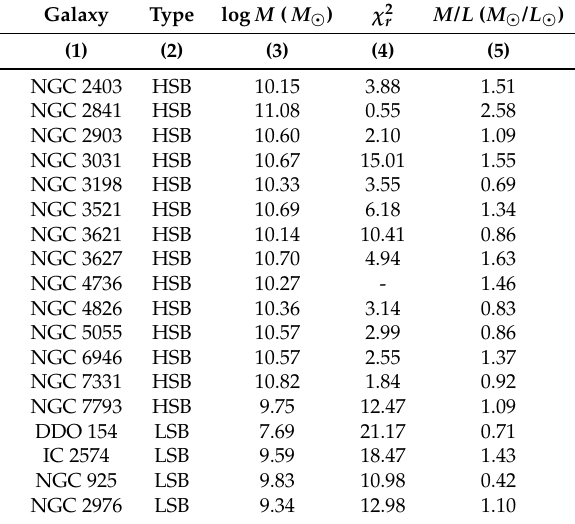
Table 2. Best fitting results using Equations (17) and (21). The corresponding rotation curves are given in Figure 2. Column (1) is the name of the galaxy; Column (2) the galaxy type; Column (3) gives best-fit results for the predicted galaxy stelar mass; Column (4) gives the values of reduced χ 2 r ; and Column (5) gives the stelar mass-to-light